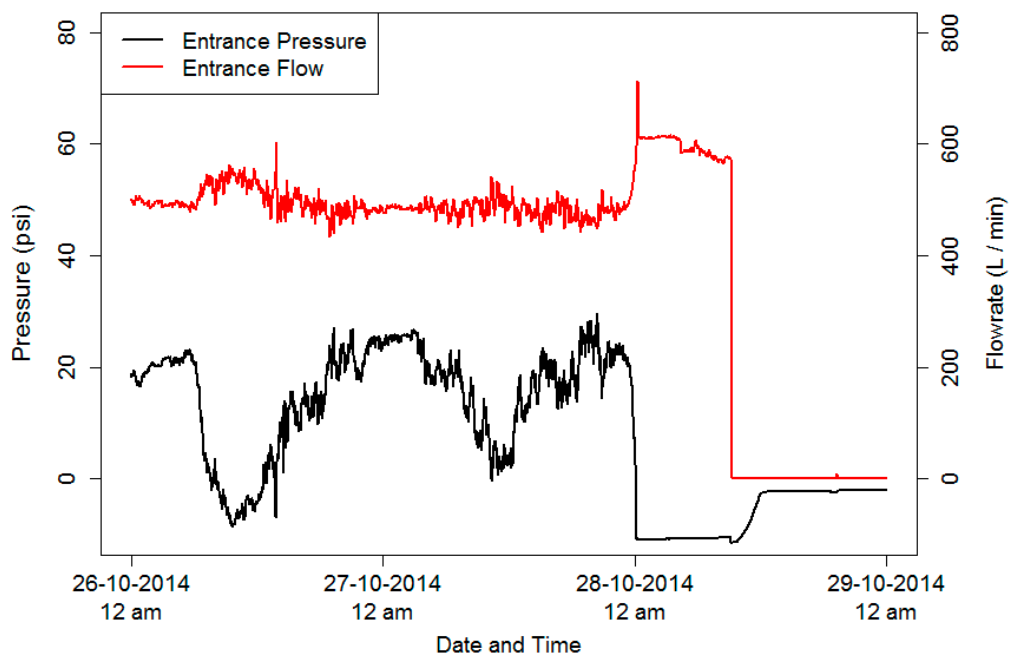
Figure 8. Continuous pressure and flow monitoring data from the Zone 3 (valve-controlled) entrance monitoring station during a break in the 4-inch pipe supplying Zone 3 (downstream of the entrance) at approximately 12 a.m. 28 October 2014.